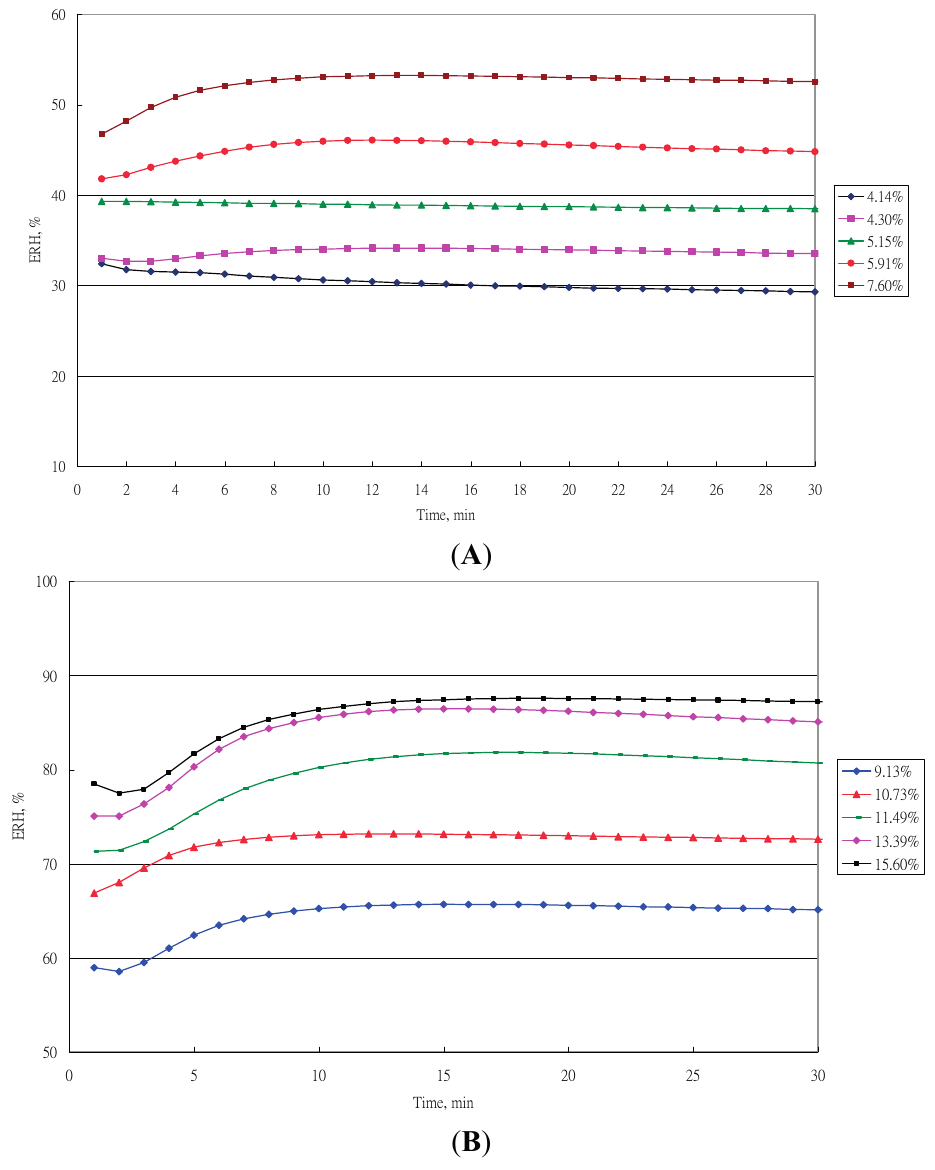
Figure 4. Equilibrium relative humidity (ERH) values of samples with five low